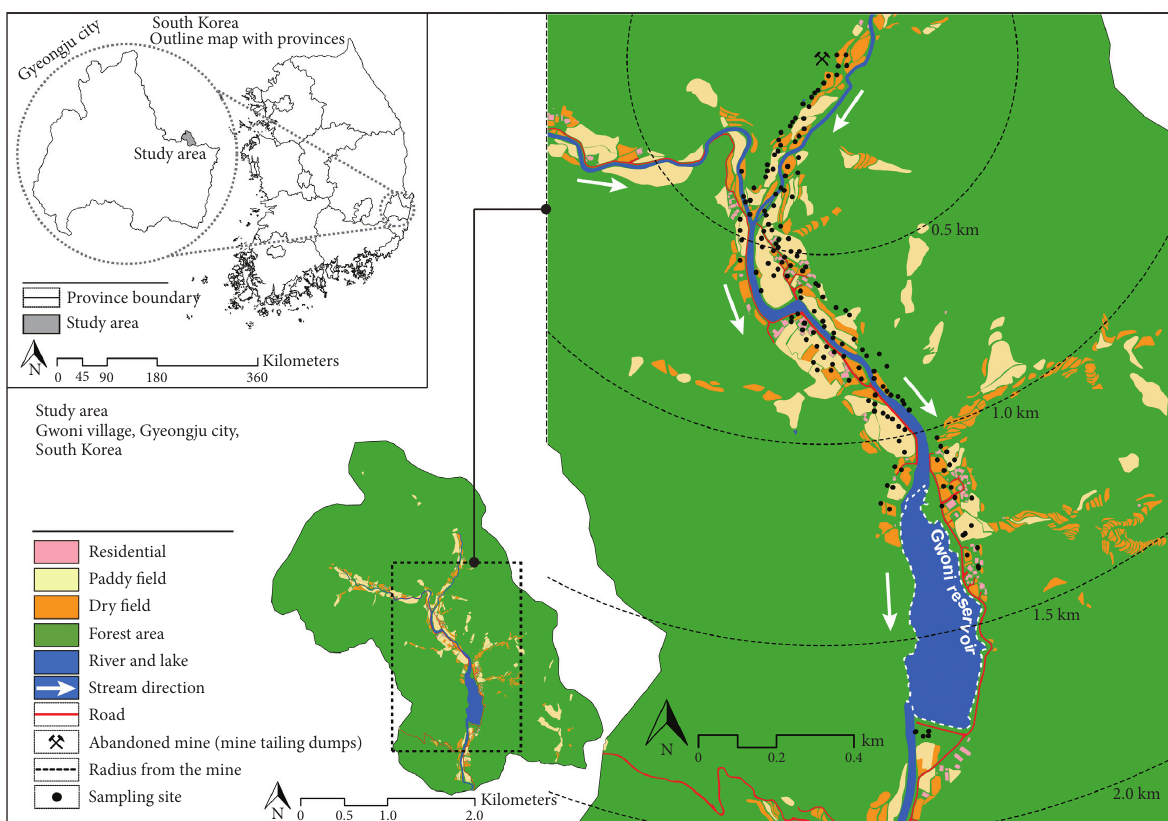
Figure 1: Sampling points in the study area, showing the distribution of land use